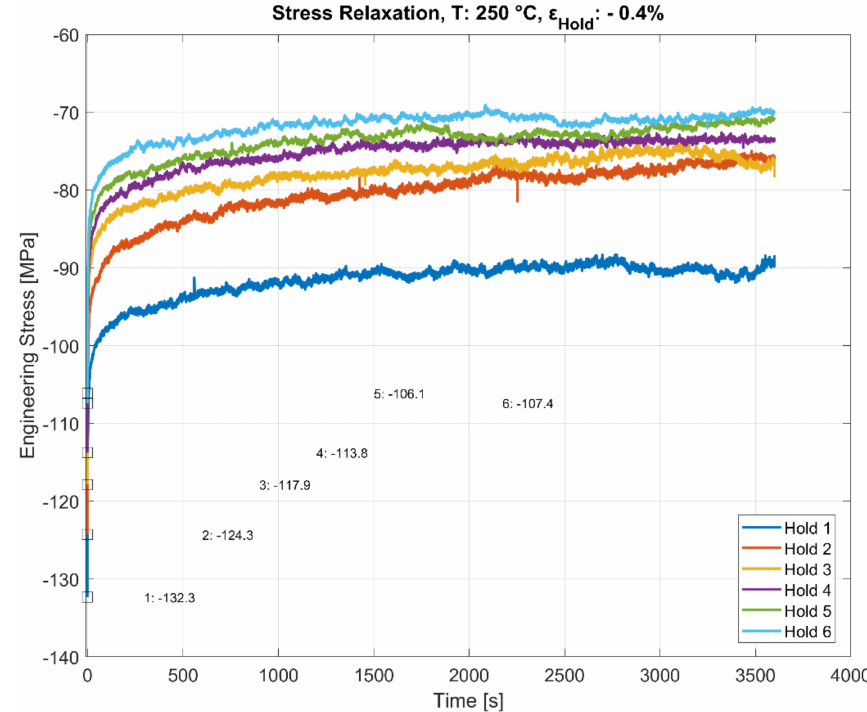
Figure 12. E ff ect of hold time on stress relaxation at 250 ◦ C with alternating fatigue loading and hold period. The start (trough) values at the beginning of each hold period (numbered 1–6) are stated in